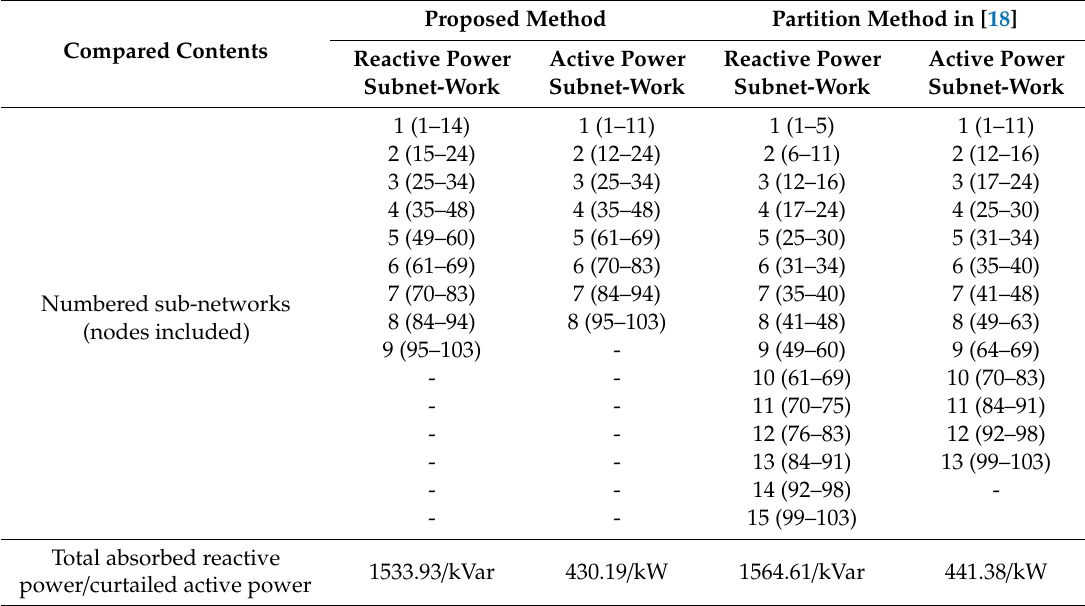
Table 2. Comparison of the Partition